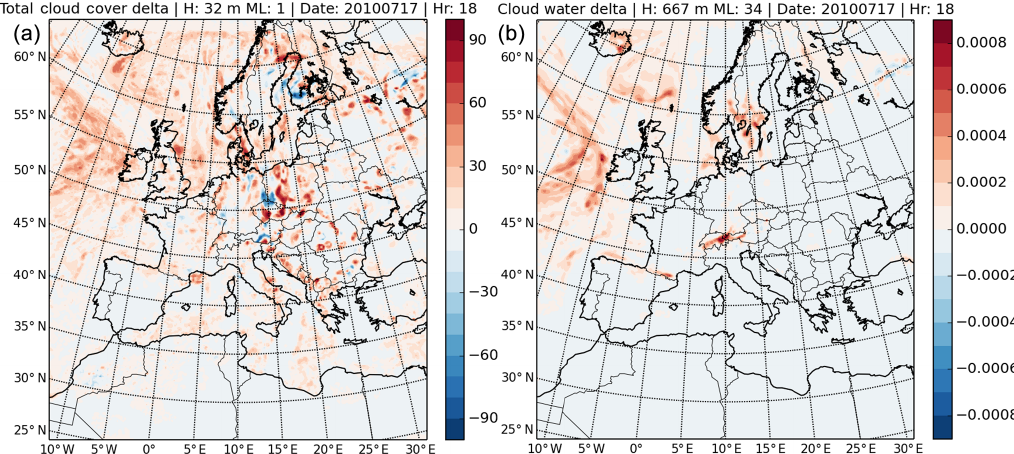
Figure 6. Delta (Enviro-HIRLAM – Reference-HIRLAM) of (a) vertically integrated total cloud cover (%) and (b) cloud water content (kgkg − 1 ) at average cloud base (667m) on 17 July 2010 at 18:00UTC.